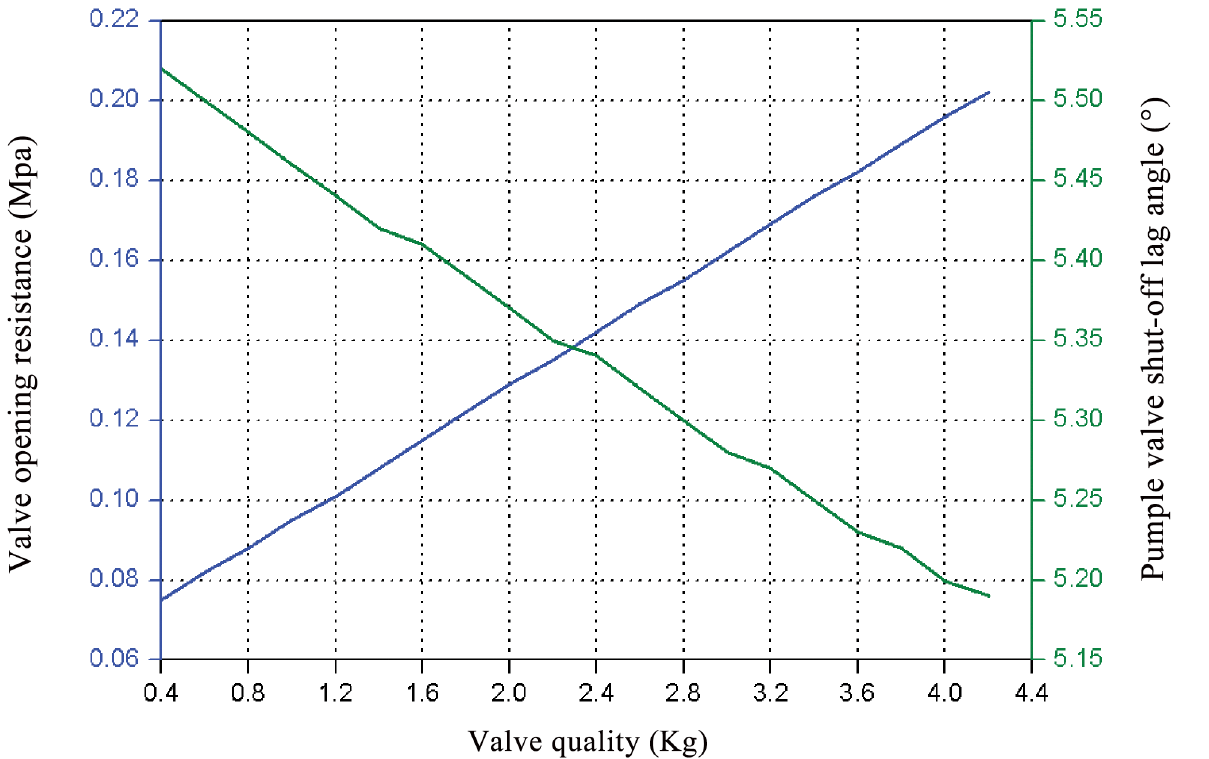
Fig 14. Curve of valve opening resistance and shut-off lag angle with respect to valve